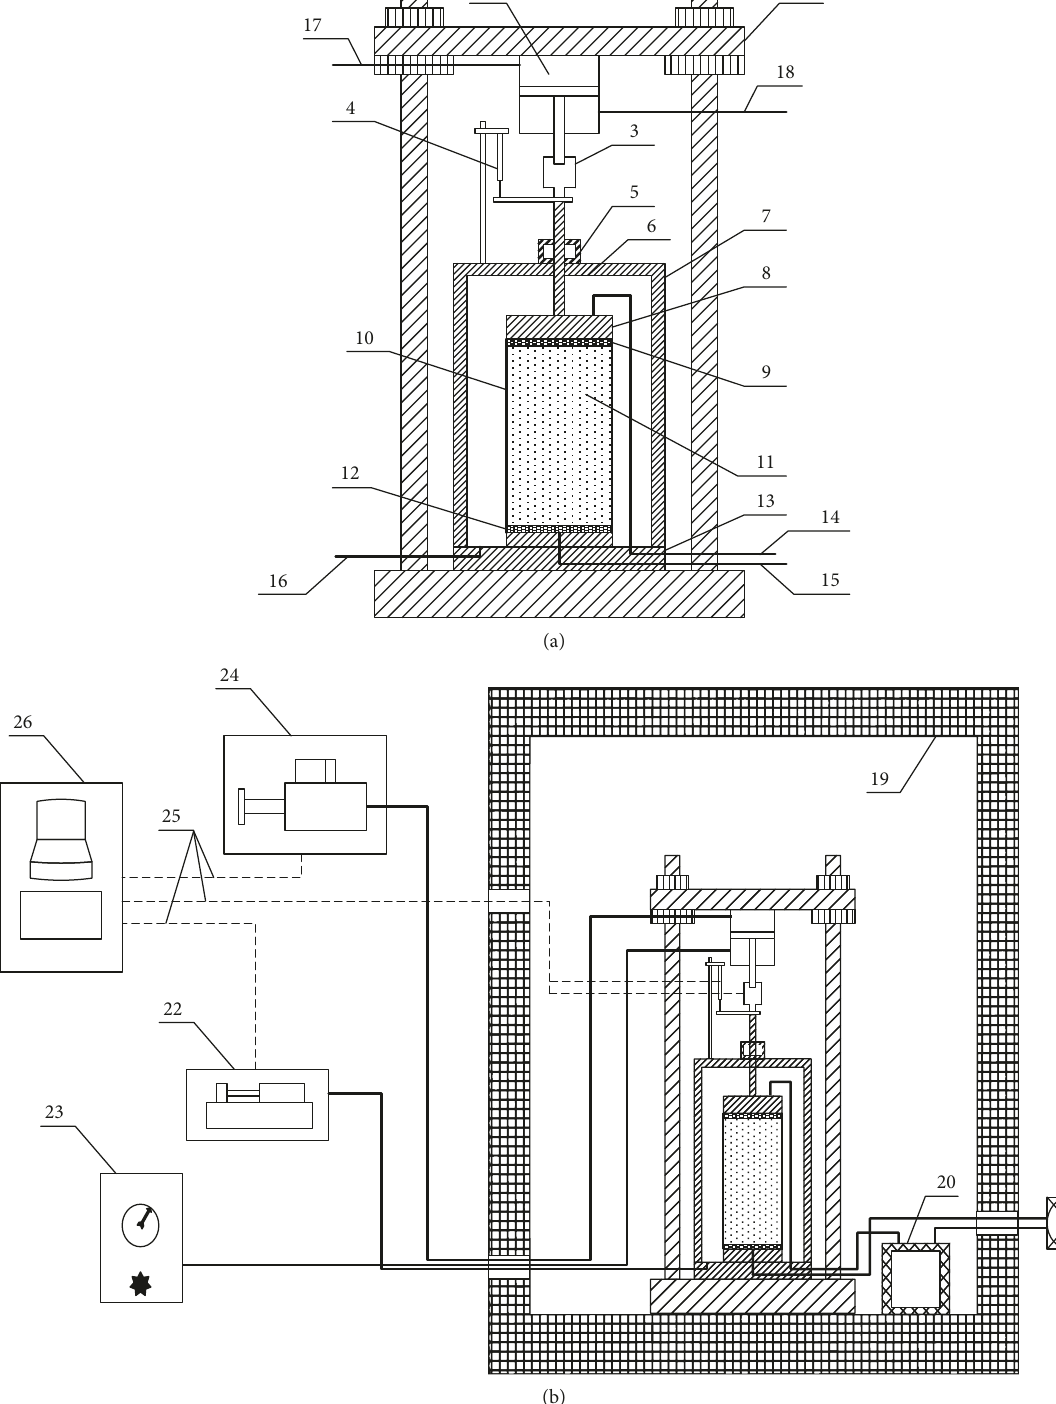
Figure 1: The sketch map of the high-temperature and high-pressure triaxial apparatus developed by Institute of Logistics Engineering. (a) The sketch map of the bench and pressure chamber. (b) The overall schematic diagram of the experimental system. 1: bench; 2: loading piston; 3: pressure sensor; 4: displacement sensor; 5: water chamber; 6: piston rod; 7: pressure chamber; 8: sample cap; 9: porous stainless steel plate; 10: latex film; 11: sample; 12: porous stainless steel plate; 13: pressure chamber pedestal; 14: circulation line of suction control gas I; 15: circulation line of suction control gas II; 16: confining pressure pipeline; 17: water pipeline of the loading piston; 18: gas pipeline of the loading piston; 19: constant temperature box; 20: salt solution jar; 21: peristaltic pump; 22: GDS pressure-volume controller; 23: control cabinet of gas pressure; 24: stepper motor; 25: data acquisition line; 26: acquisition and control